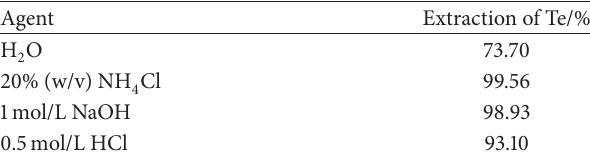
Table 8: Effect of diverse ions on Te(IV)